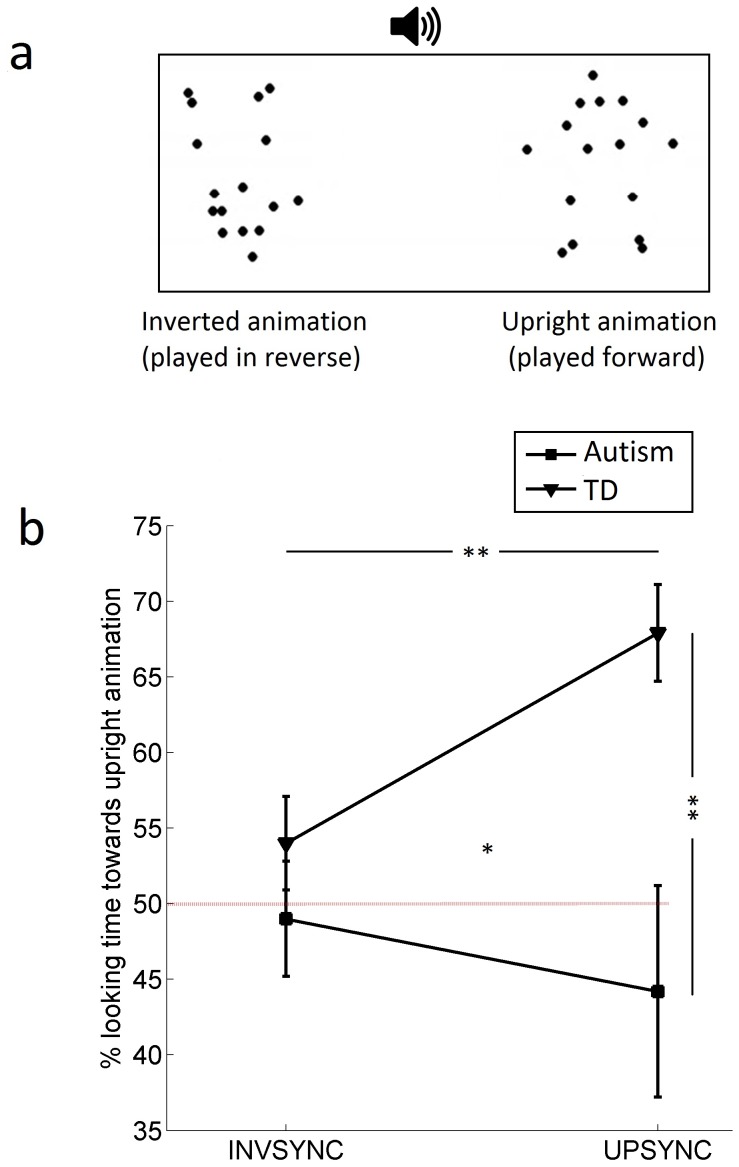
Stimuli and results.
a) The two conditions (UPSYNC, INVSYNC) were visually identical but differed with regard to the distribution of audiovisual synchrony (AVS) across the two animations. Adopted with permission from ref. [11]. b) Looking preference ([upright animation]/[upright+inverted animation], in percent) was modulated by AVS only in typically developing children (TD), and AVS specifying distorted biological motion (INVSYNC condition) blocked these children’s preference for biological motion. Children with autism performed at chance level (50%) in both conditions. Error bars represent standard error of the mean; *p<.05; **p<.01.